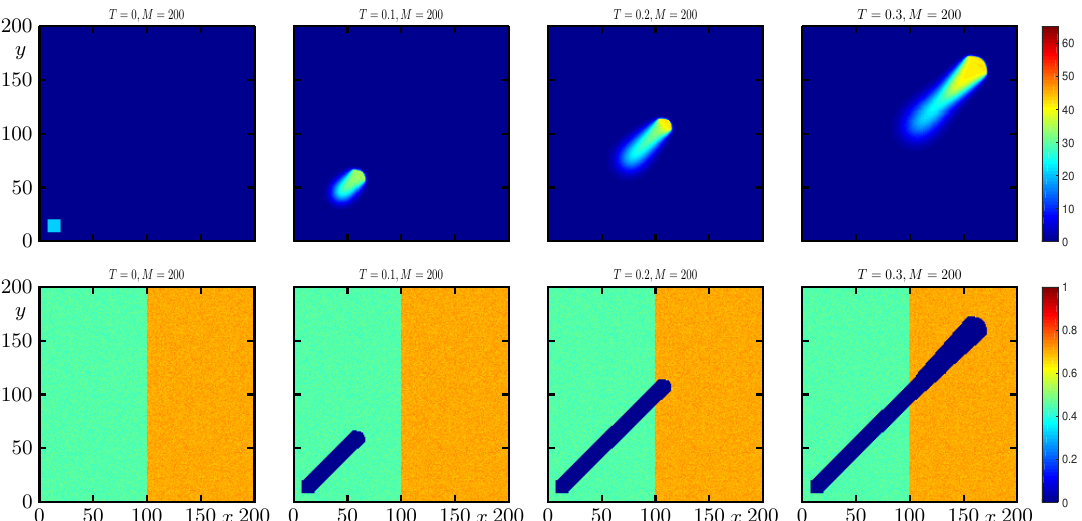
Figure 4. Example 2: Evolution of the dynamics of temperature ( top ) and fuel ( bottom ). Simulation when the wildfire enters a region with higher fuel density.